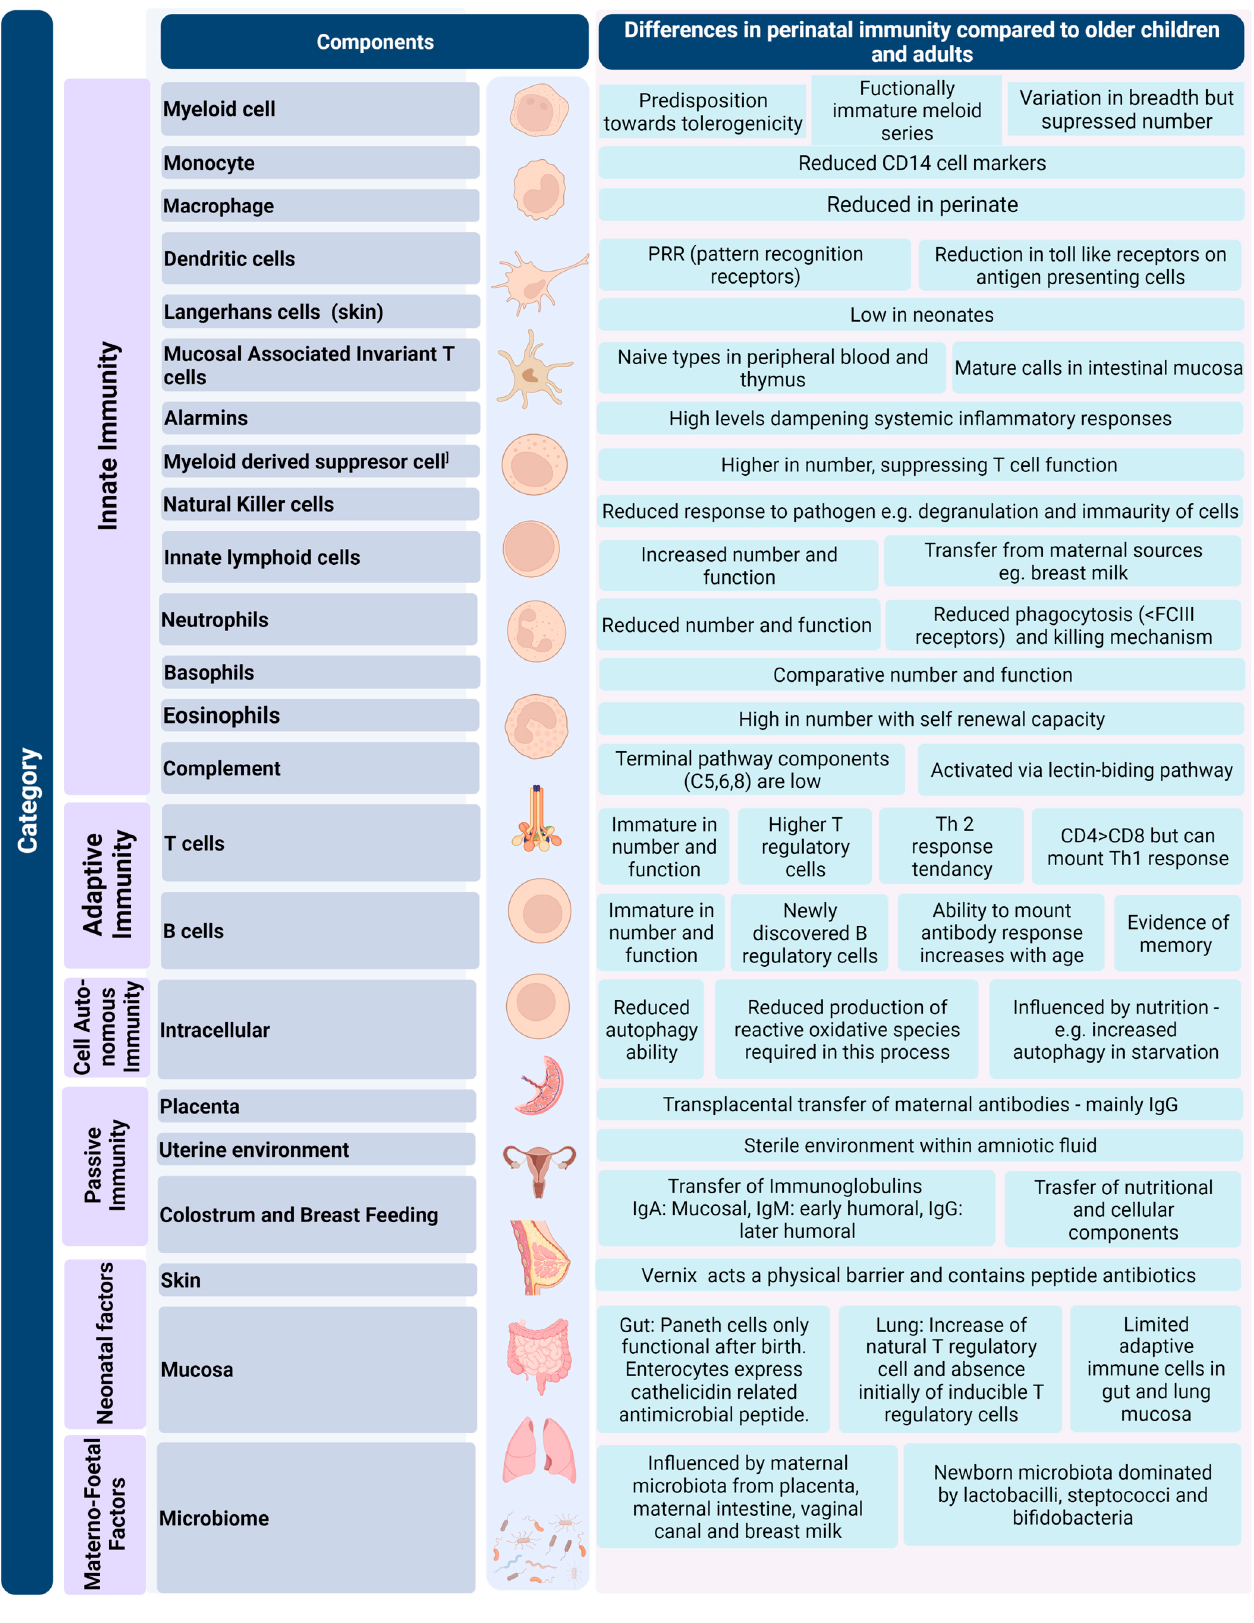
Figure 1. The perinatal immune repertoire: examples of differences in defence and immunity in the perinatal period compared to older children and adults. Image created using Biorender.com (accessed on 29 May 2022).